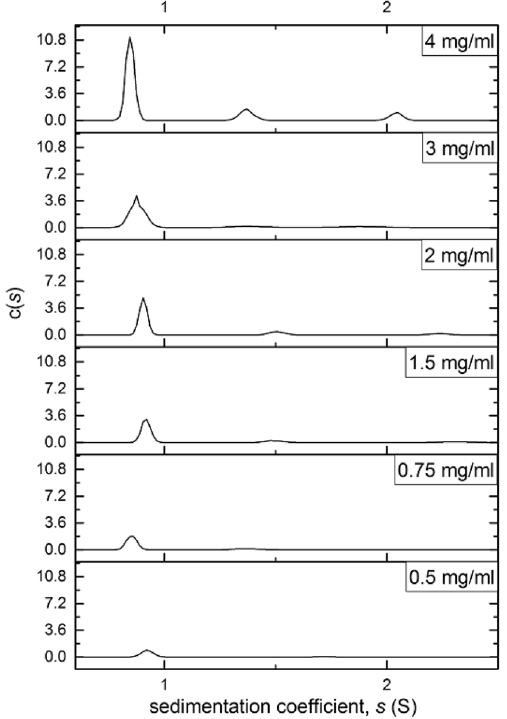
Figure 5. Sedimentation velocity sedimentation coefficient distributions c( s ) vs s for TPA5 in isopropanol. Distributions obtained by the SEDFIT approach of Dam and Schuck 61 . Rotor speed = 49,000